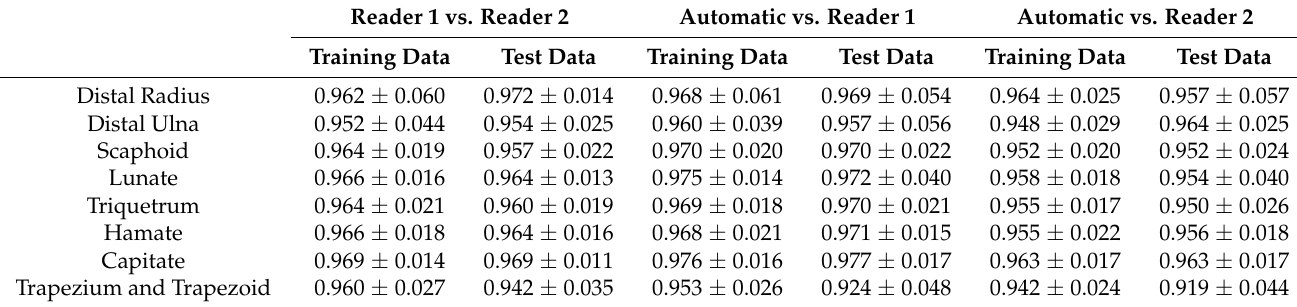
Table 2. Similarity of manual and automatic segmentations as indicated by dice similarity coefficients (DSC, mean ± standard deviation) for each of eight classes, i.e., anatomic forearm or carpal bones. Manual reference segmentations were performed by two radiologists, i.e., reader 1 and reader